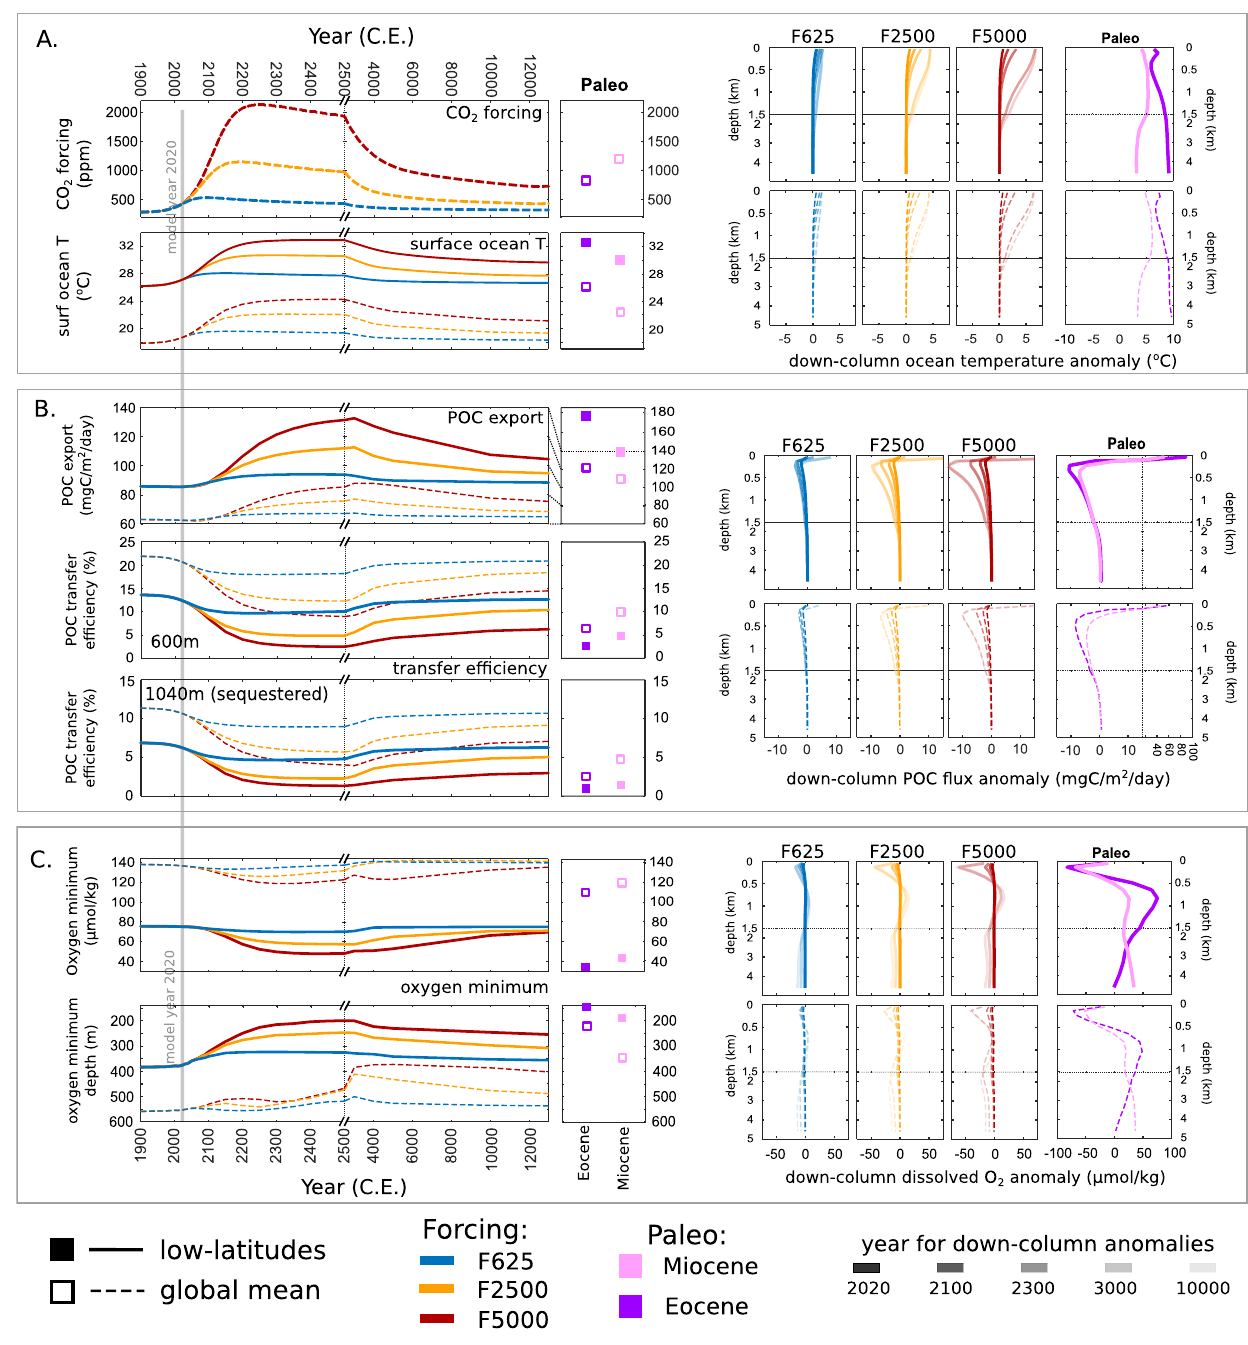
Fig. 3 | Modeled indicators for projected future scenarios, global (solid lines) and low-latitude (dashed lines) means. A CO 2 forcing, surface ocean tempera- ture, and down-column time slices for temperature as anomalies from the pre- industrial. B Particulate organic carbon (POC) exported at 80m and transfer ef fi ciency to 1040m (and 600m the mid-Twilight Zone), and down-column time slices for POC fl ux as anomalies from the preindustrial (note y-axis scale change